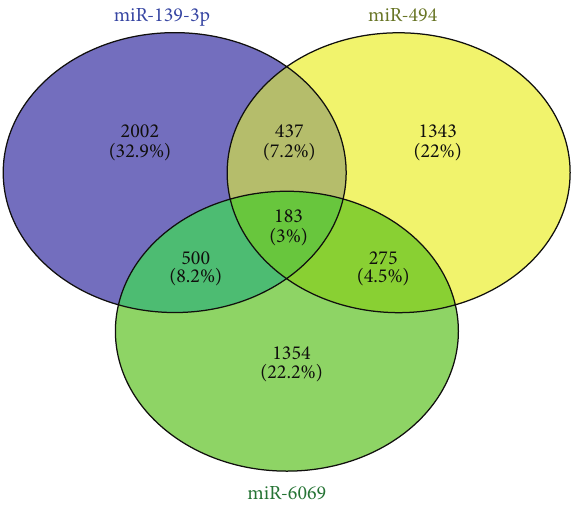
Figure 4: Target gene prediction for the 3 downregulated miRNAs, miR-494, miR-139-3p, and